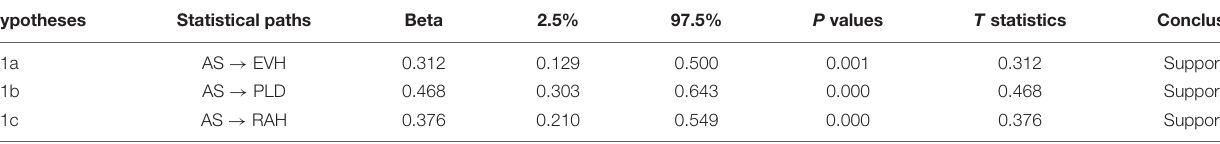
TABLE 4 | Direct effects.